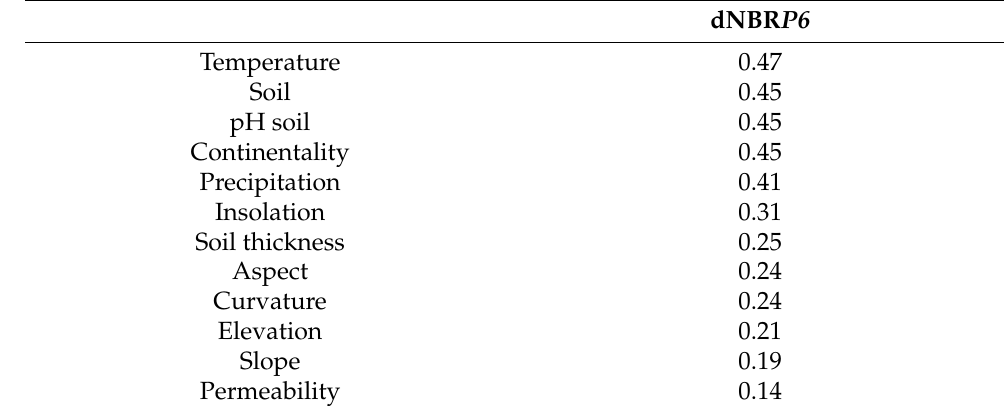
Table 6. Correlation coefficients between dNBR P6 and environmental biophysical variables (signifi- cance level: p <